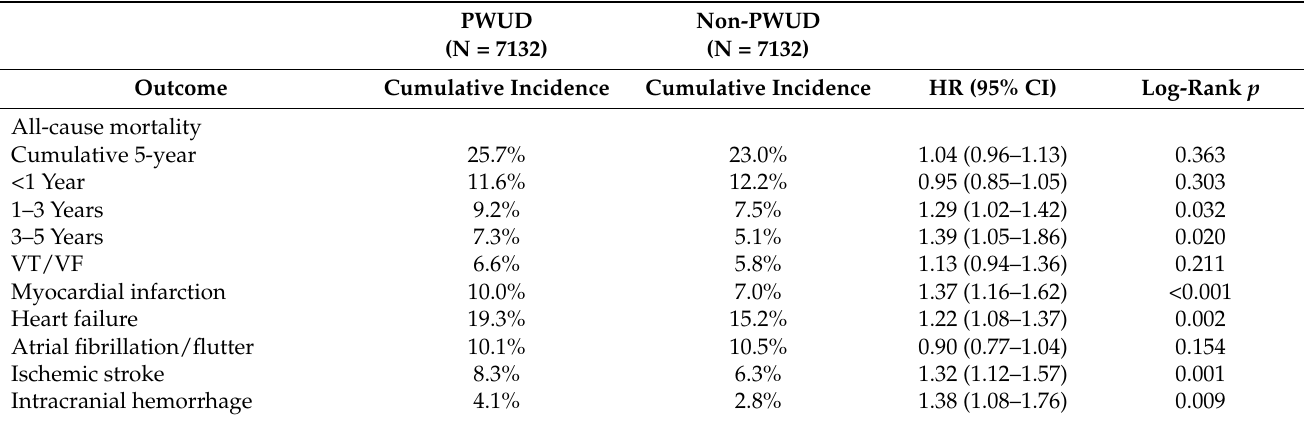
Figure 1. Five-year cumulative incidence of mortality after a first episode of infective endocarditis in people who use drugs (PWUD) vs. non-PWUD patients. Table 2. Cumulative 5-year outcome incidence after propensity score matching.